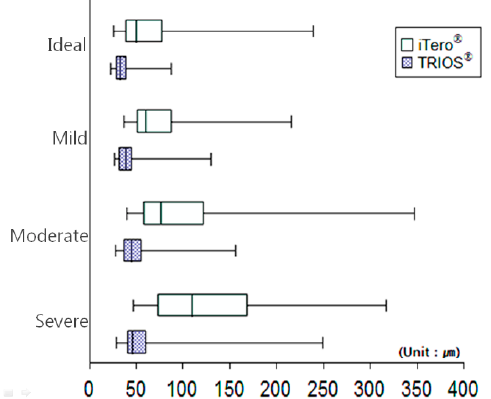
Figure 9. Boxplot showing deviations among four models in the scanned images from iTero ® and Trios ® . For the sectioned arch, Ant is the anterior teeth; LP is the left premolars; RP is the right premolars; LM is the left molars; RM is the right molars; Total is the entire arch. The plot shows median, 25% quartile, 75% quartile and maximum-minimum range.